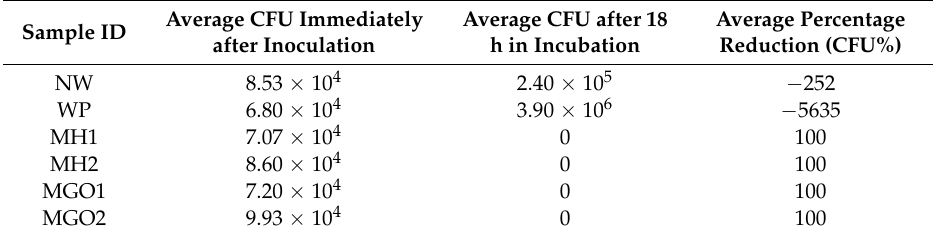
Table 3. Average reduction in colony forming units (CFU) for K. pneumoniae . Negative values indicate bacteria